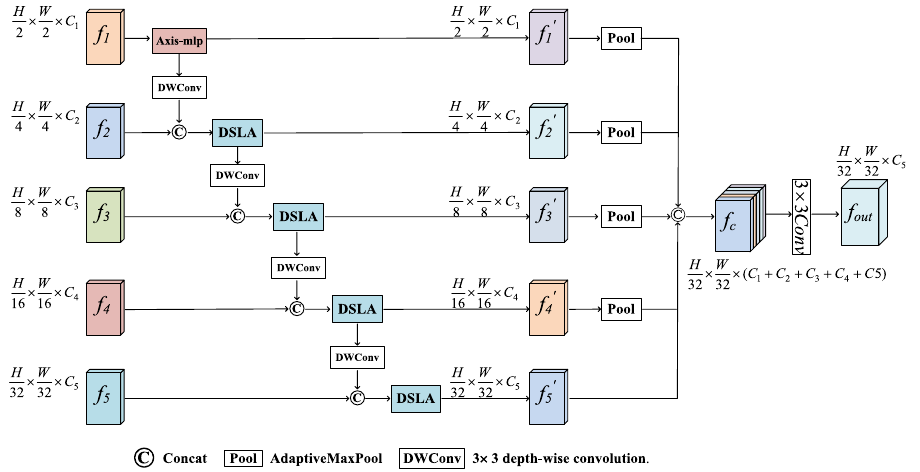
Figure 2. Overall architecture of HMSF module (created by ‘Microsoft Office Visio 2013’ URL: https:// www. micro soft. com/ zh- cn/ micro soft- 365/ previ ous- versi ons/ micro soft- vision-